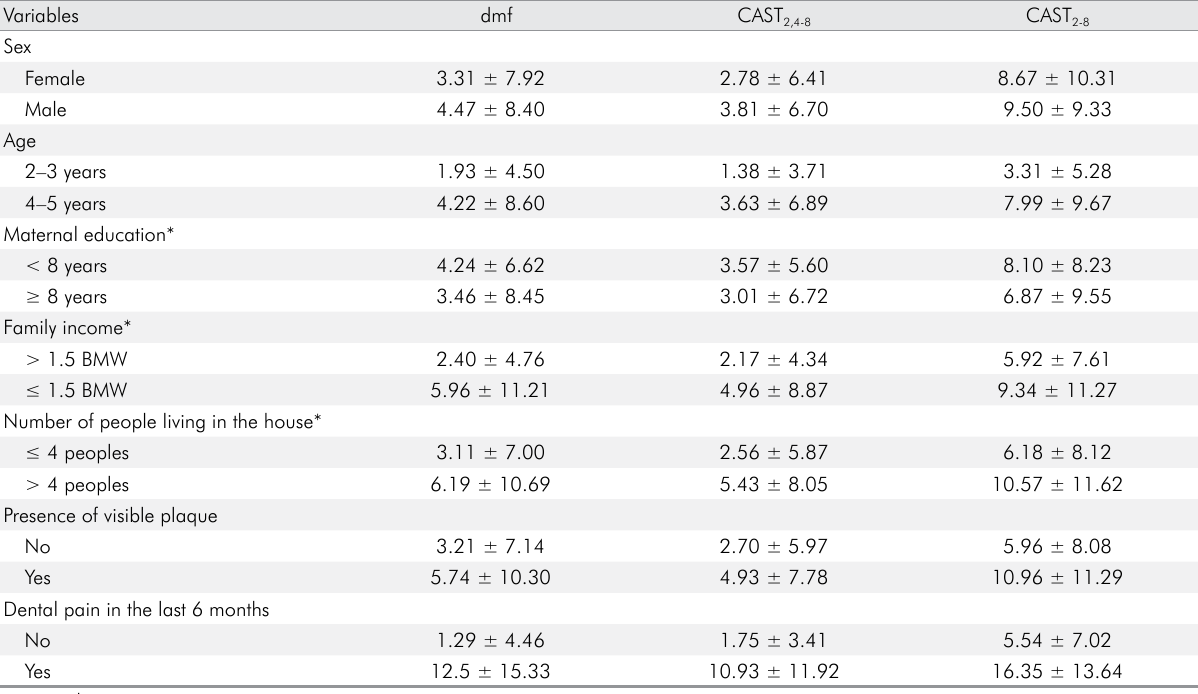
Table 2. Caries experience (mean ± SD) according to the CAST at thresholds CAST independent variables (n =